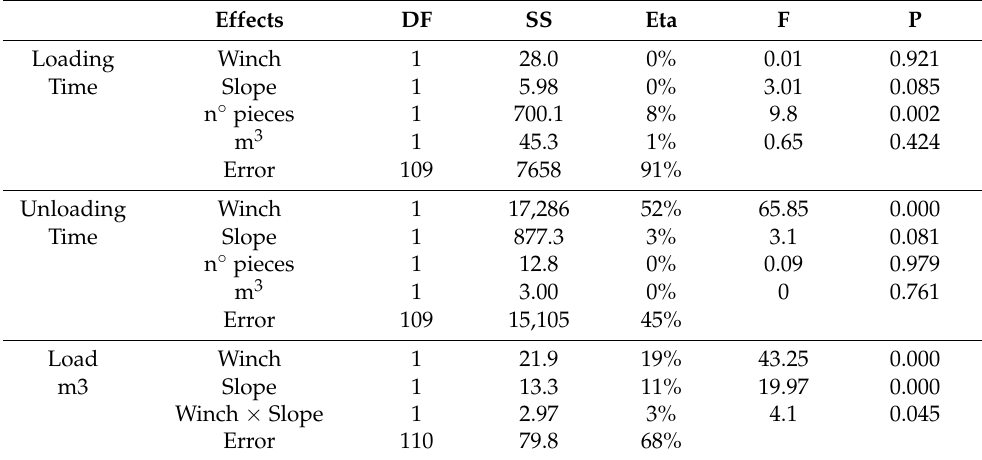
Table 6. Results of the GLM analysis for the loading time, unloading time and load